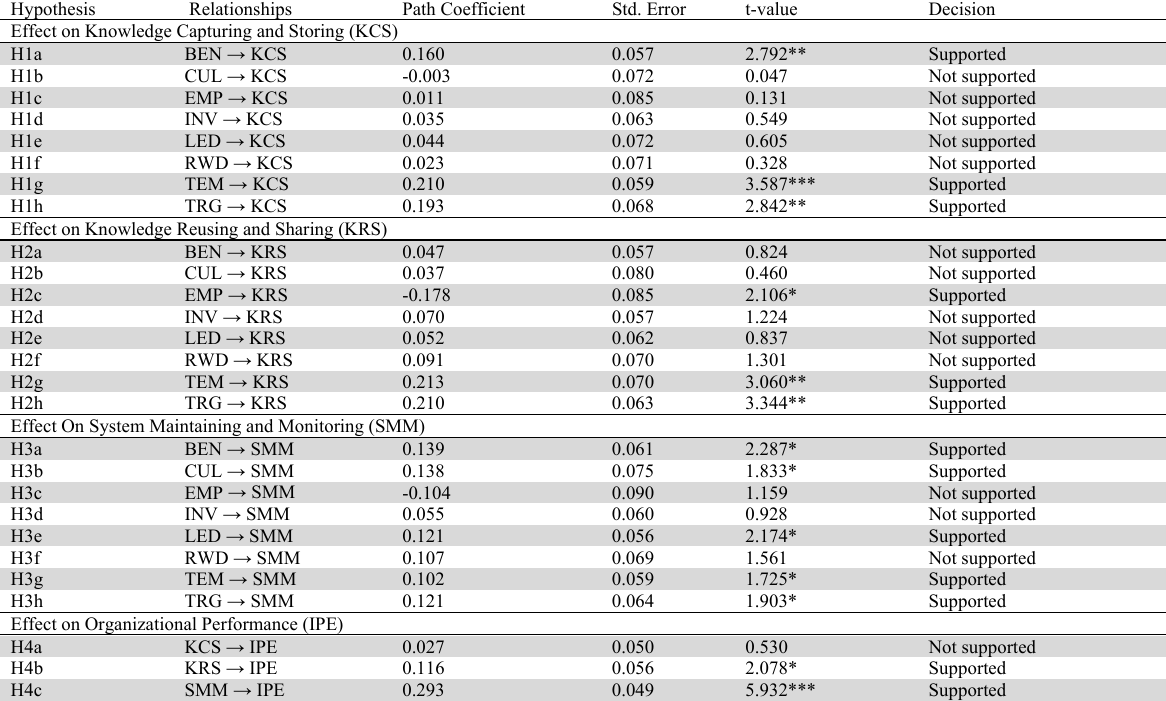
Path Coefficient and Hypothesis Testing (Direct